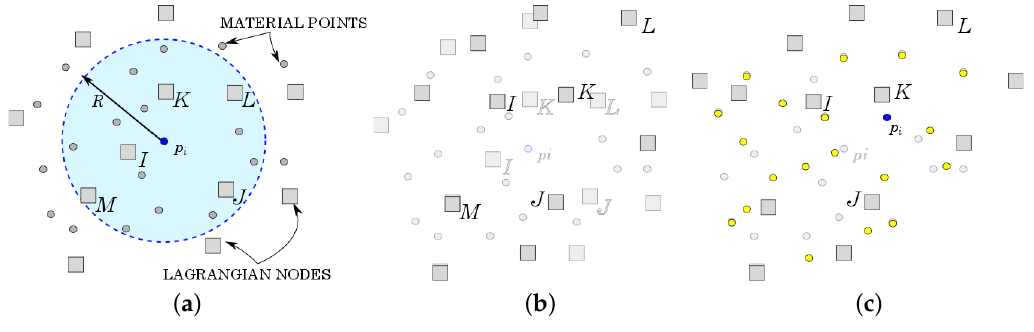
Figure 3. GMM phases. ( a ) Initialization phase; ( b ) Updated Lagrangian FEM phase; ( c ) Convective phase. Algorithm 2 GMM